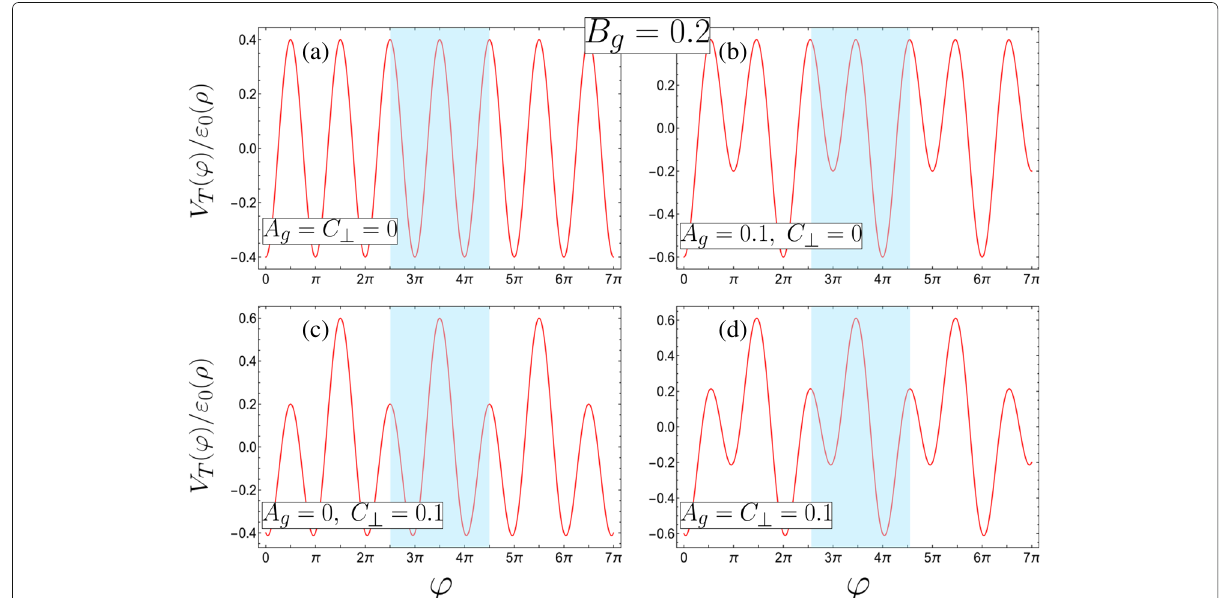
Fig. 2 The four possible superlattice potential configurations with the unit cells highlighted in blue (defined in terms of the dimensionless parameters, see Eq. 3 for the corresponding requirements of the physical parameters, and all with B g = 0.2). a A unary superlattice with degenerate minima and maxima in the unit cell ( A g = C ⊥ = 0). b – d Binary superlattices formed from either b an asymmetric DQW with differing minima and internal reflection symmetry about either minima due to degenerate maxima ( A g = 0.1, C ⊥ = 0), c a symmetric DQW with degenerate minima only ( A g = 0, C ⊥ = 0.1), or d an asymmetric DQW with differing minima and maxima ( A g = C ⊥ =